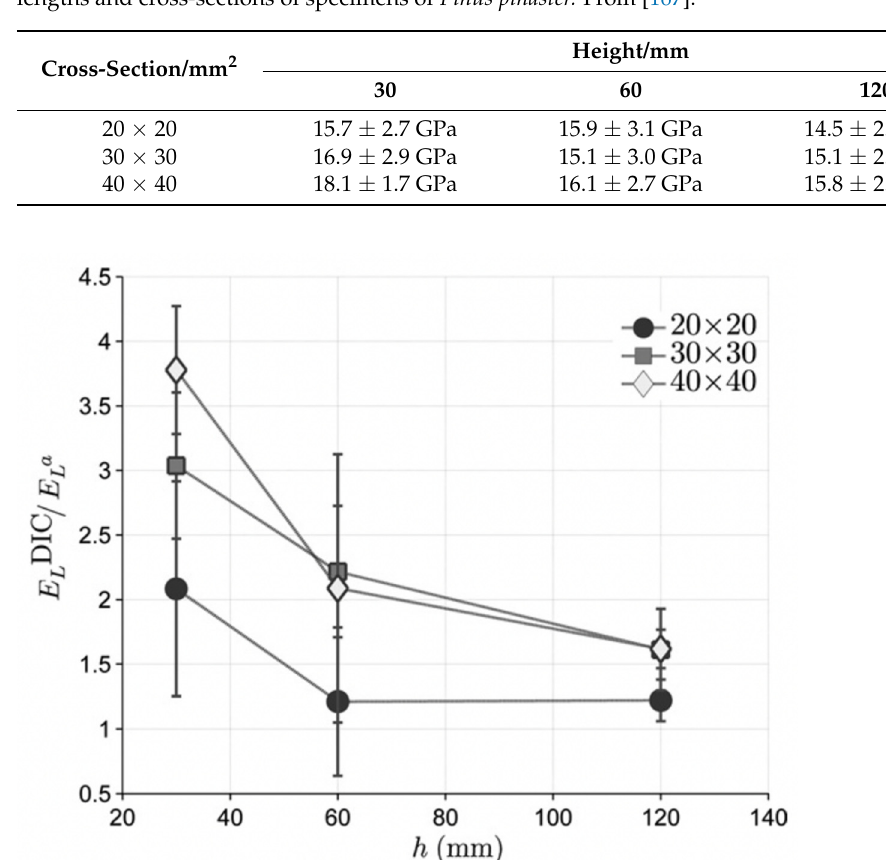
Figure 50. Plot of the ratio of elastic moduli measured two different ways for Maritime Pine specimens against specimen length for three different cross-sections. The two methods used were (i) optical (digital image correlation, DIC) and (ii) mechanical (a displacement transducer). From [167].